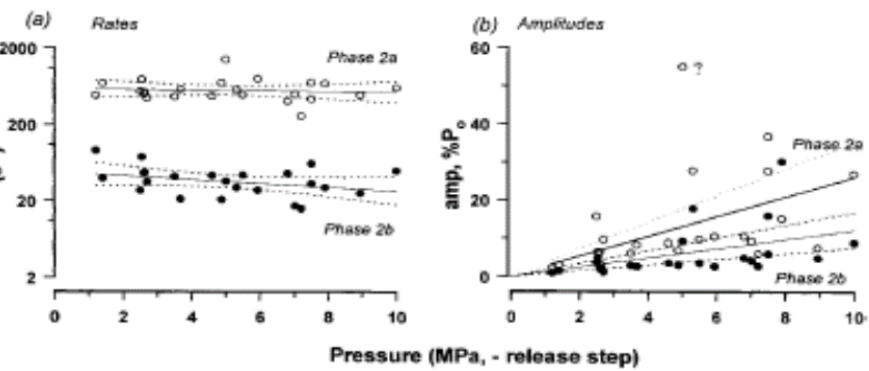
Figure 18. ( a ) The rates of the two exponential components (Phases 2a and 2b) are not correlated with pressure-jump amplitude ( p > 0.1); the mean rate was ~600/s for Phase 2a and ~40/s for Phase 2b 20. ( b ) The amplitudes of the two components (as % tetanic tension), increase with amplitude of release (from Vawda, Geeves, and Ranatunga, 1999 [20]).